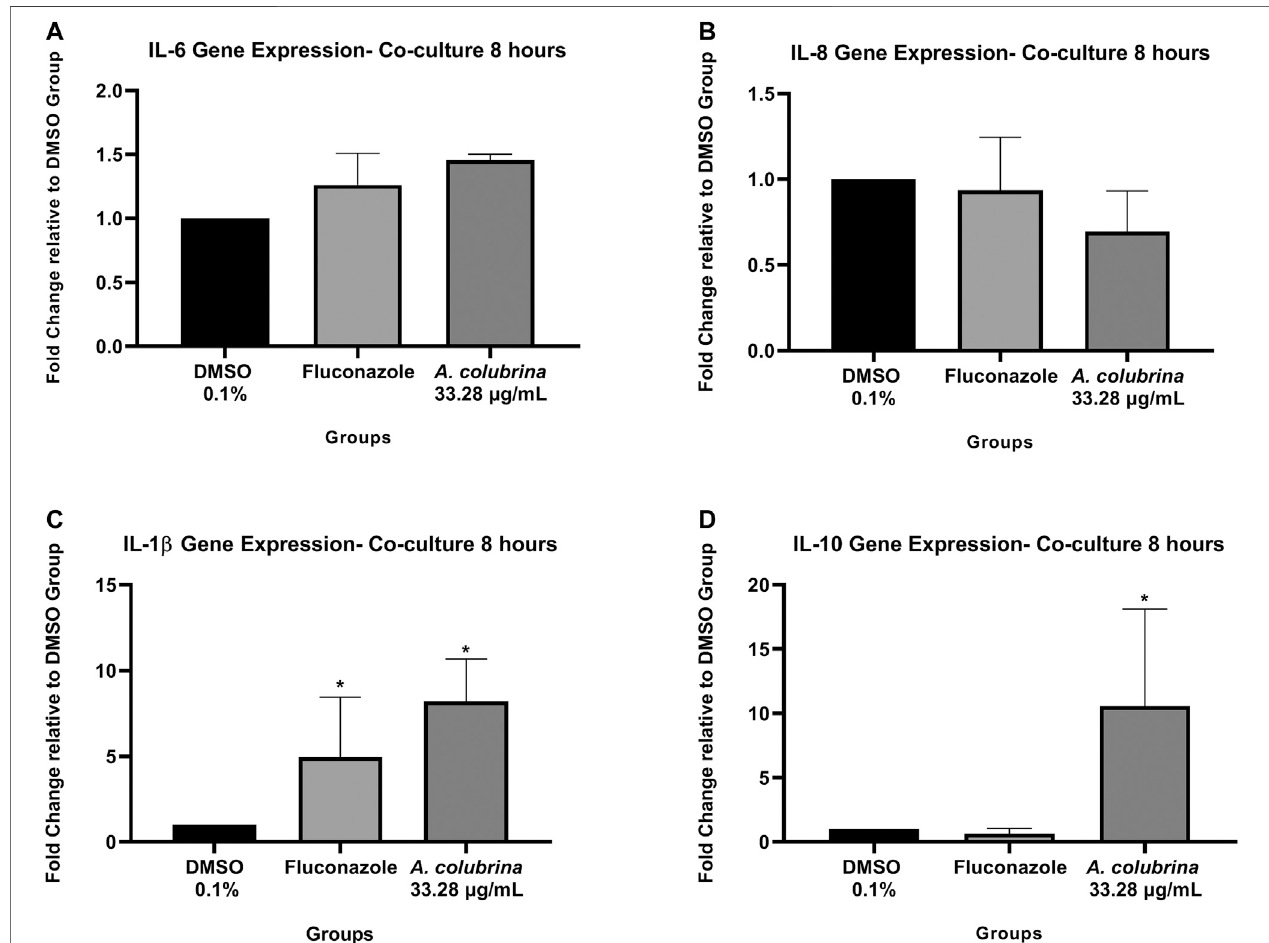
FIGURE 7 | Real-time quantitative information about relative gene expression of (A) IL-6; (B) IL-8; (C) IL-1 β ; and (D) IL-10 of human gingival fi broblasts after 8 h of infectionby C.albicans andtreatmentwith A.colubrina extract(33.28 μ g/ml).DMSO0.1%:vehiclecontrol;Fluconazole(10 μ g/ml):positivecontrol.Valuesareshownas the fold-change relative to the vehicle control group. Values shown with asterisk (*) are statistically signi fi cant when compared to the vehicle control ( p < 0.05).